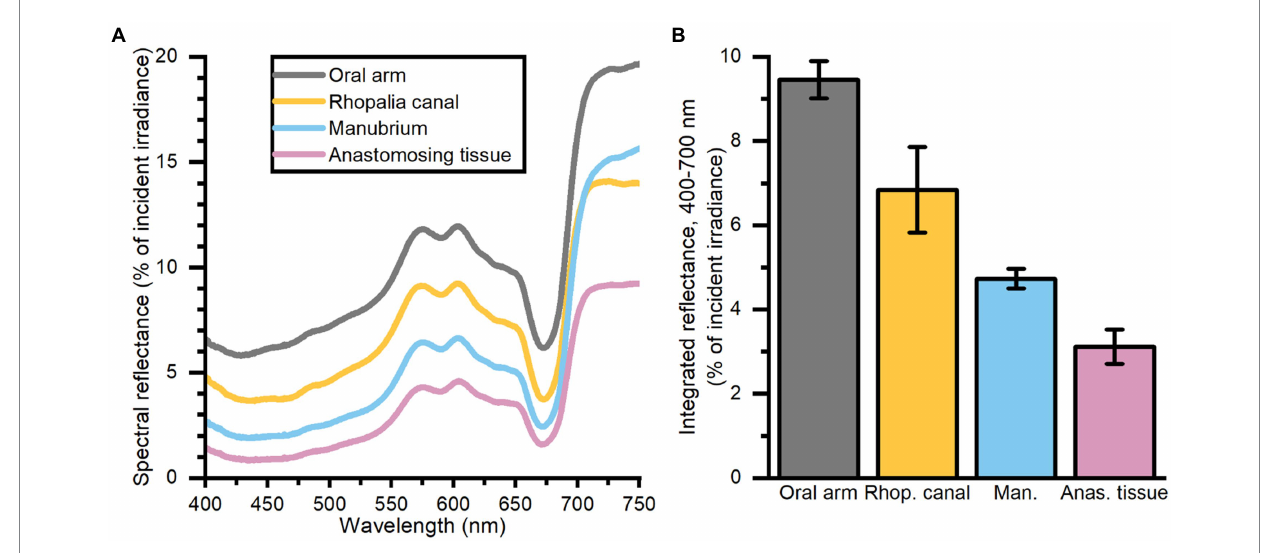
FIGURE 2 Spectral reflectance (in % of incident irradiance) (A) measurements, and integrated reflectance (400–700 nm) (B) averaged for 4 areas of interest depicting differing morphological tissue regions of one large Cassiopea medusa. Data represent mean ± SEM ( n = 3 for each tissue type). For increased clarity standard errors are not shown in panel (A) , but are reflected in the ±SEM shown for integrated values in panel (B)